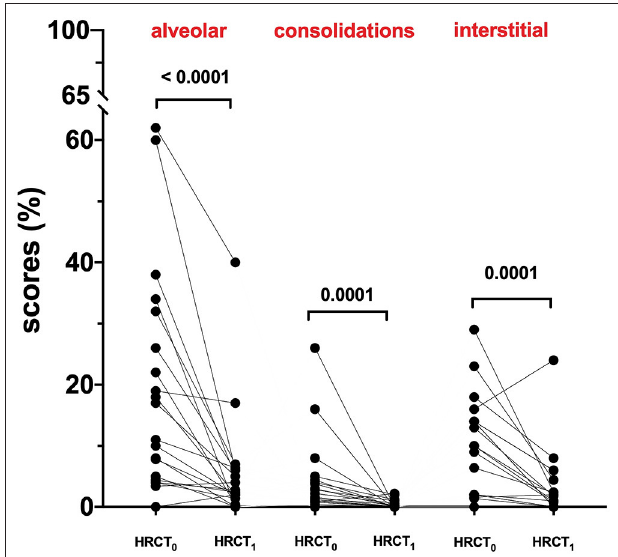
FIGURE 3 | HRCT scores of the not recovery population (NOT-REC) from HRCT0 to HRCT1: ALV. [from 14 (0.0–62.0) to 2.6 (0.0–40.0); p < 0.0001], CONS [from 1.9 (0.0–26.0) to 0.0 (0.0–2.2); p = 0.0001] and INT [1.5 (0.0–29.0) to 1.4